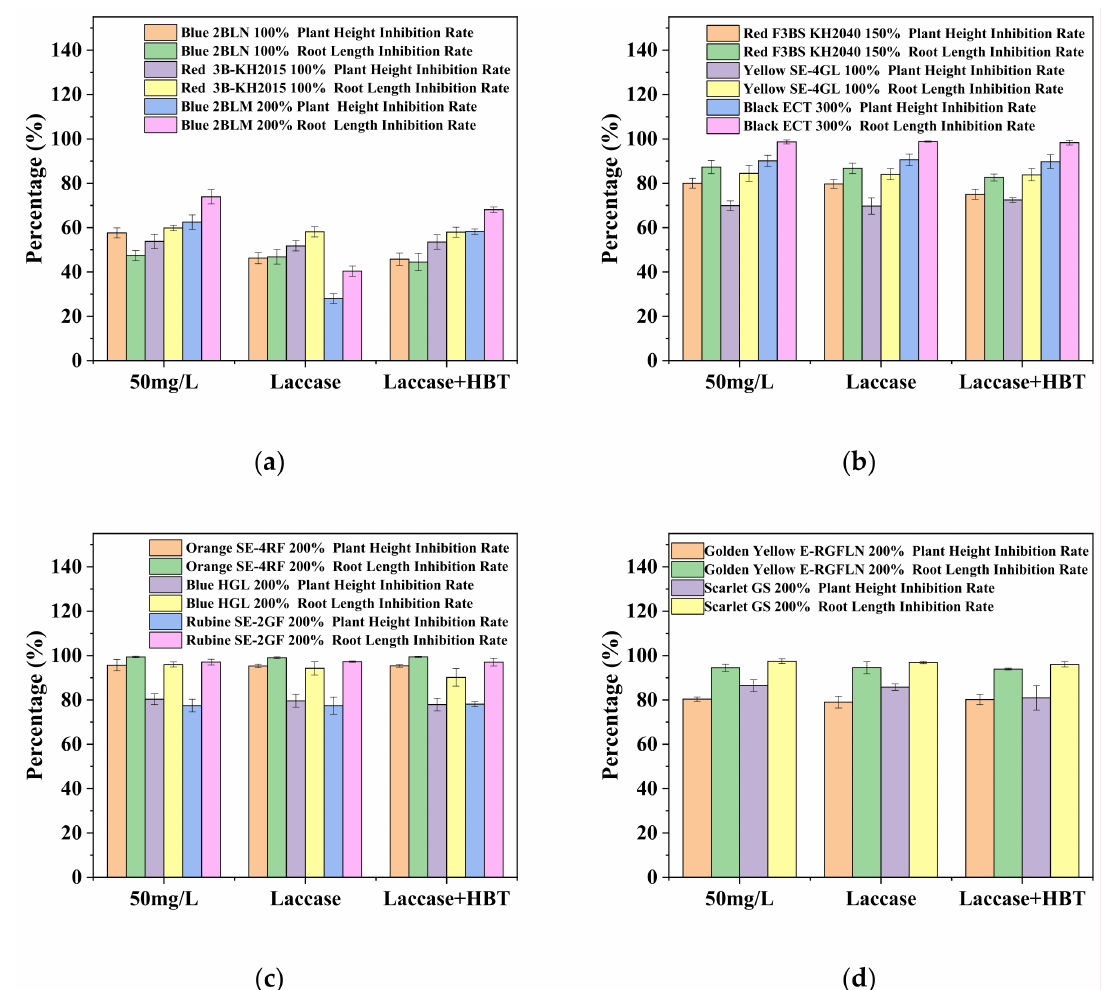
Figure 5. Inhibition rate of shoot and root elongation of wheat sprout under different treatments: deactivated laccase, laccase, and laccase + HBT. ( a ): Blue 2BLN 100%, Red 3B-KH2015 100%, and Blue 2BLM 200%; ( b ): Red F3BS KH2040 150%, Yellow SE-4GL 100%, and Black ECT 300%; ( c ): Orange SE-4RF 200%, Blue HGL 200%, and Rubine SE-2GF 200%; ( d ): Golden Yellow E-RGFLN 200% and Scarlet GS 200%.3.4. Oxygen Uptake by Aerobic AS in Different Dye